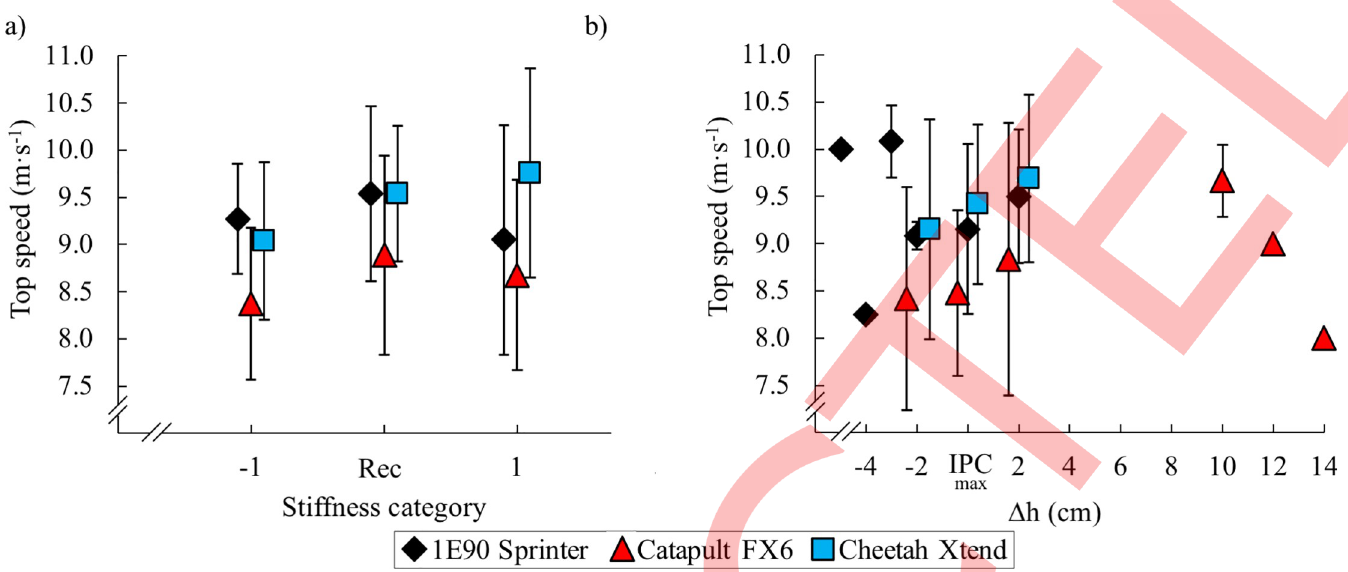
Fig 2. Average maximum speed as a function of: a) stiffness category (Rec is the recommended category) and b) change in prosthetic height ( Δ h) compared the International Paralympic Committee maximum allowable height (IPC max). Error bars represent standard deviations. We found no effect of RSP stiffness category (p = 0.836) or height (p = 0.762) on maximum speed. Use of the J-shaped Cheetah Xtend and 1E90 Sprinter RSPs resulted in 8.3% and 8.0% faster maximum speeds, respectively, compared to the C-shaped Catapult FX6 RSPs (p < 0.001).